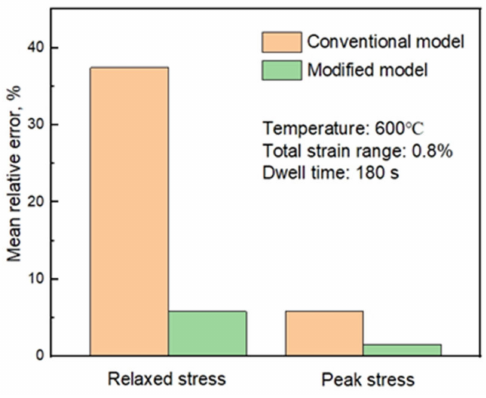
Figure 9. The simulation capability of the conventional and modified models for relaxed stress and peak stress.